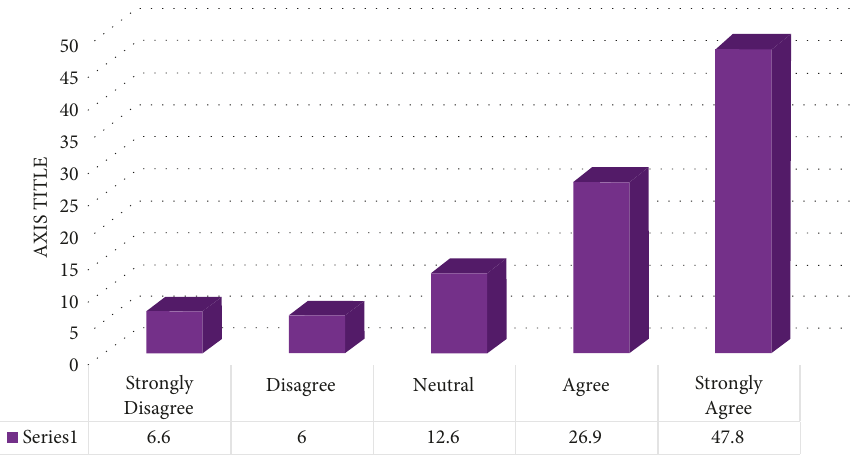
Figure 2: enhanced data standardisation. Table 3: medical